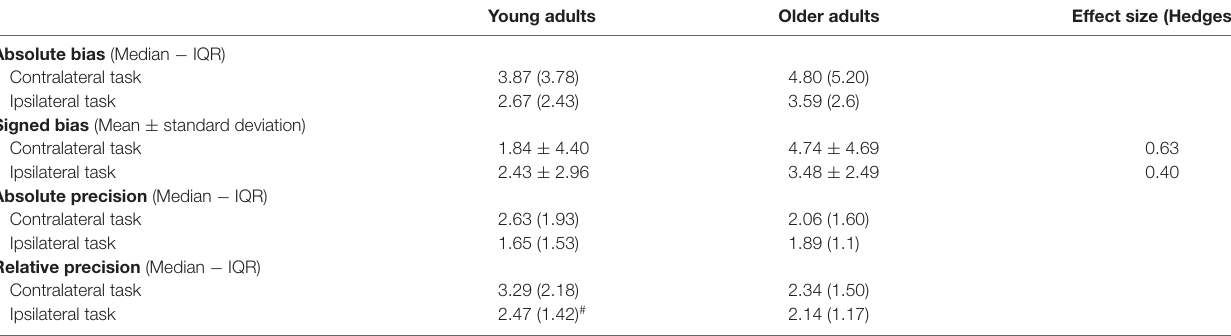
TABLE 1 | Absolute and signed values of proprioceptive bias and precision in young and older